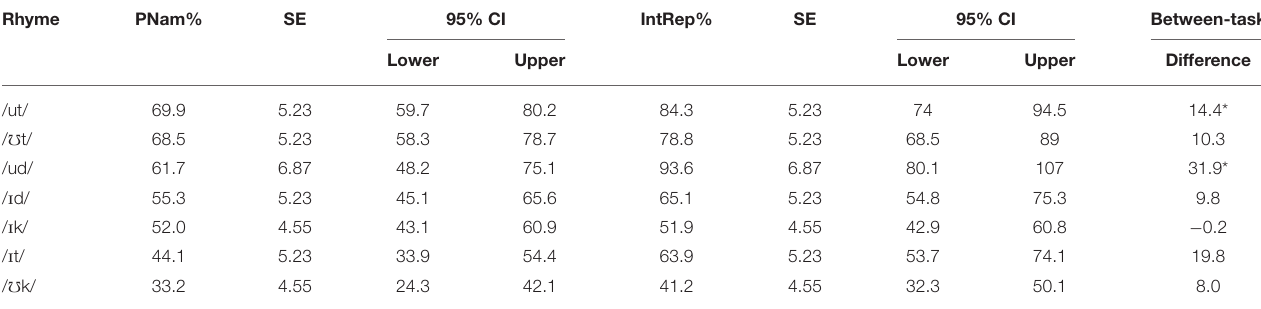
TABLE 4 | Mean intelligibility by rhyme and task (included rhymes